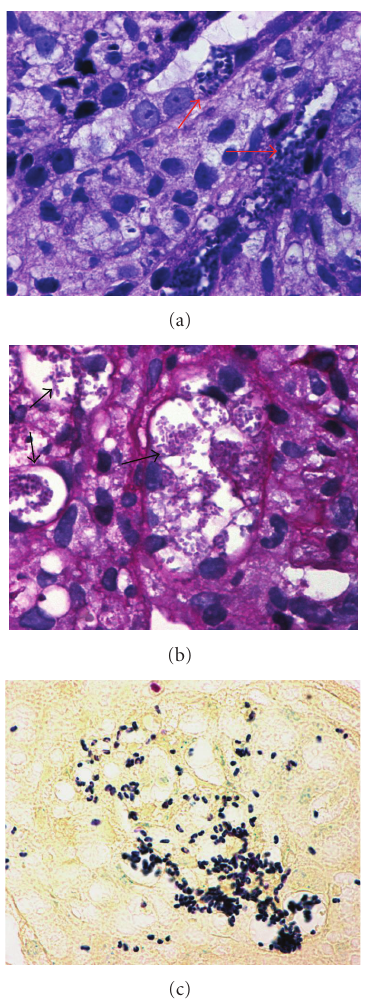
Figure 1: (a) H&E stain: tubular epithelial cells show para- sitophorous vacuoles, with abundant microsporidia spores (arrow). (b) Spores are not strongly stained with the PAS stain. (c) Warthin Starry stain strongly stains the spore.